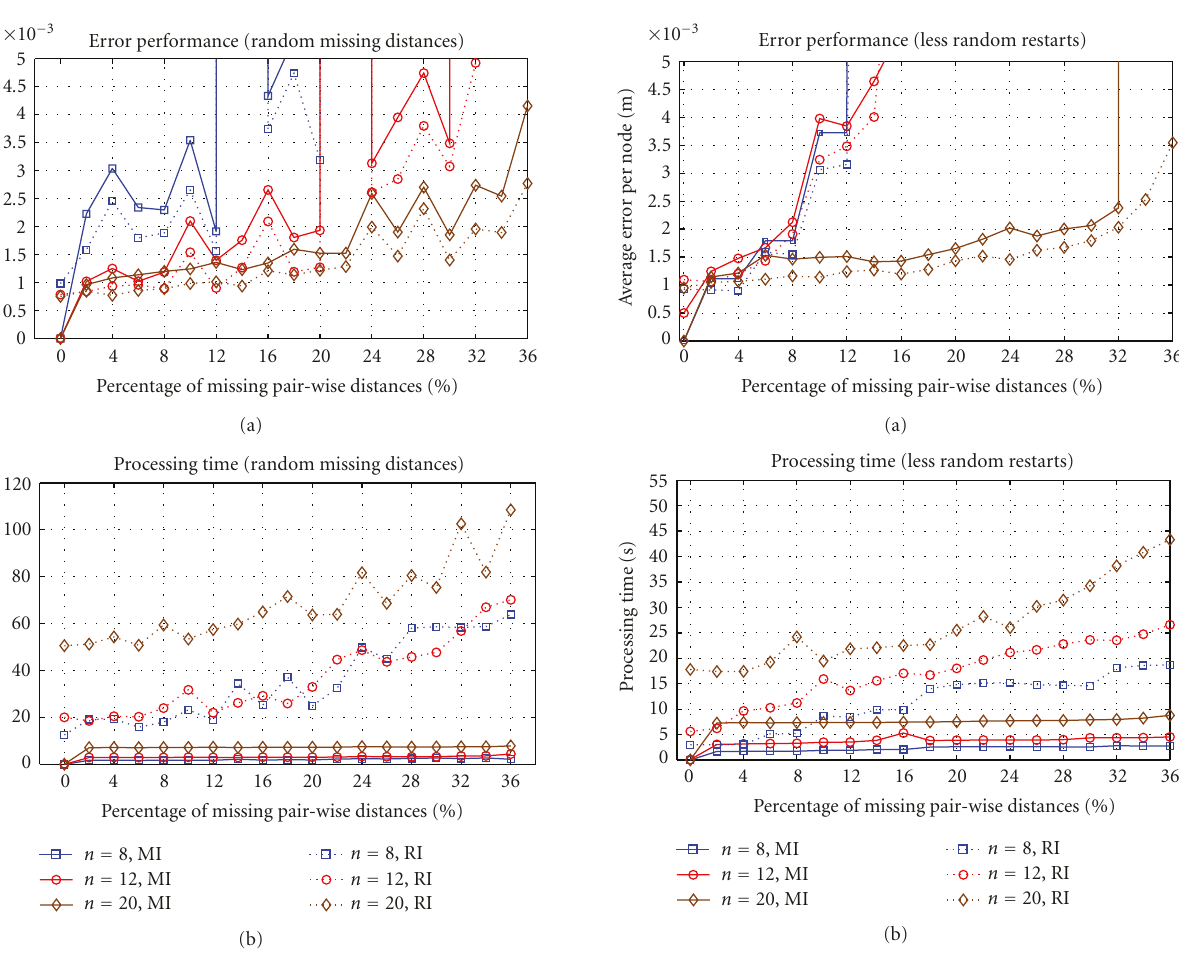
Figure 5: (a) Error performance; (b) processing time versus percentage of missing pairwise distances using ideal distances, where the missing distances are randomly selected.